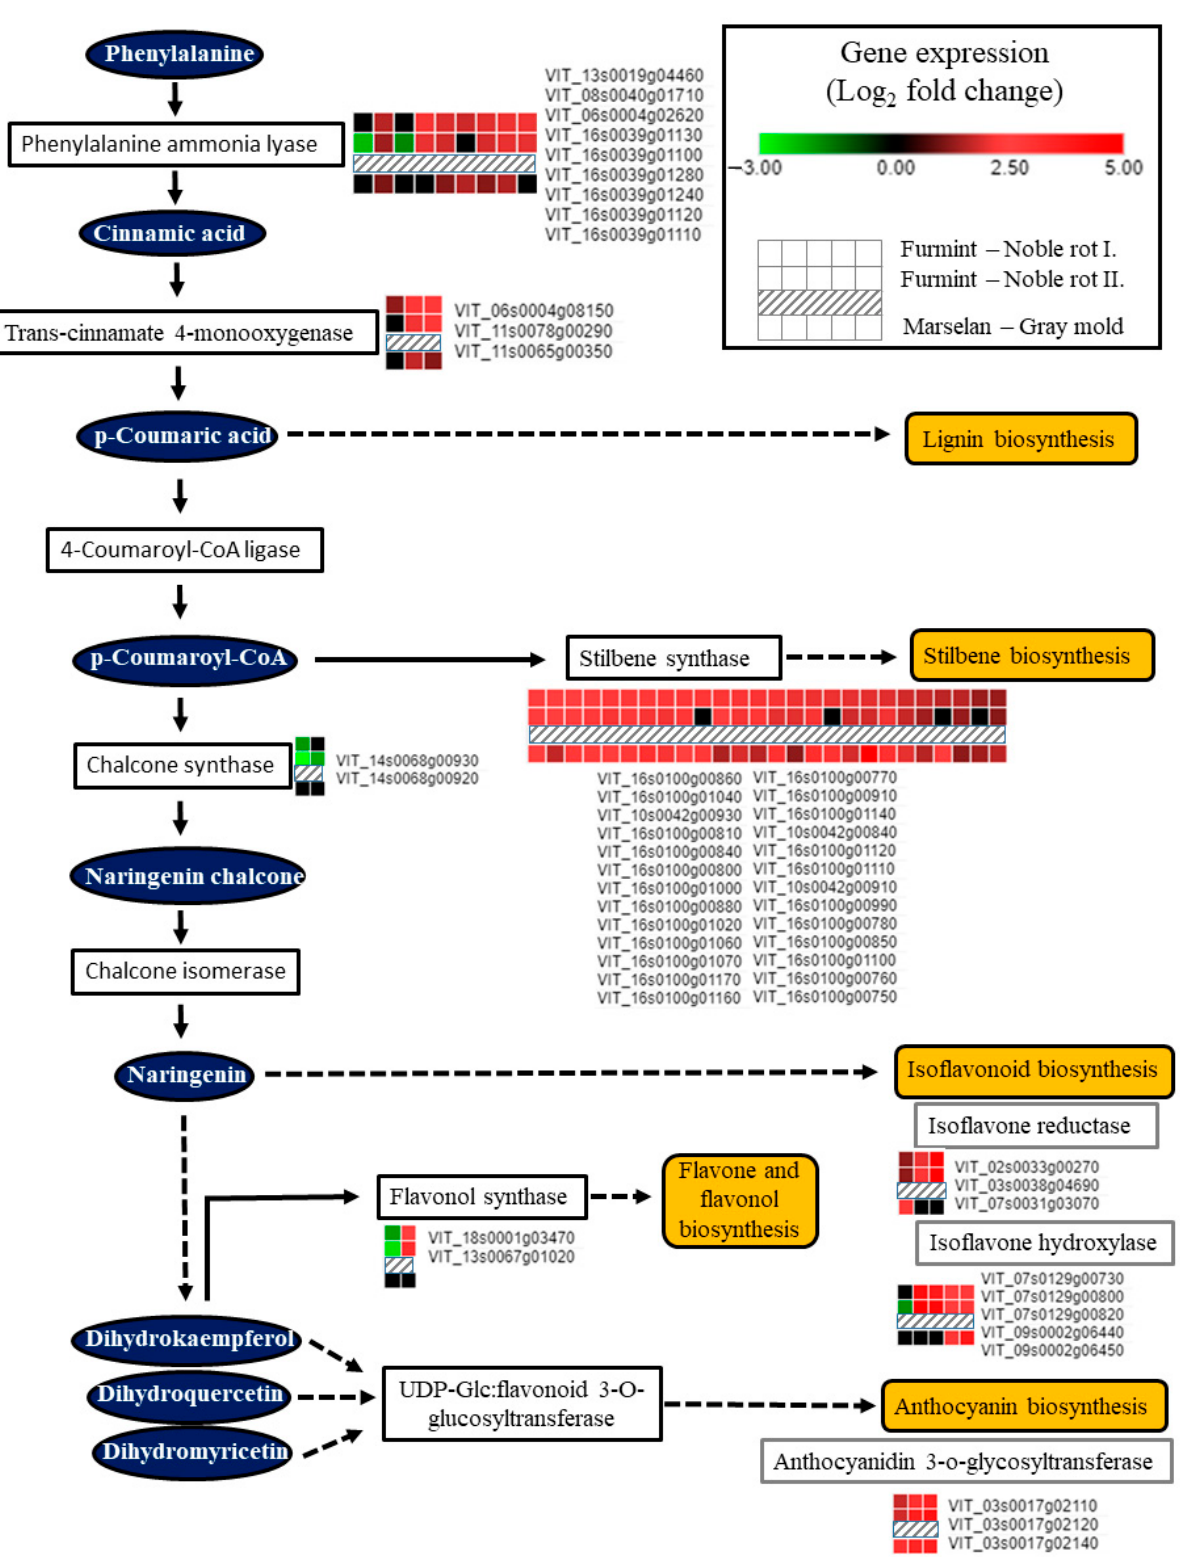
Figure 7. Transcription of genes encoding components of the phenylpropanoid pathway is greatly affected by noble rot in Furmint (analyzed in this study). Bunch rot also results in a marked transcriptional change observed in Marselan berries [2].